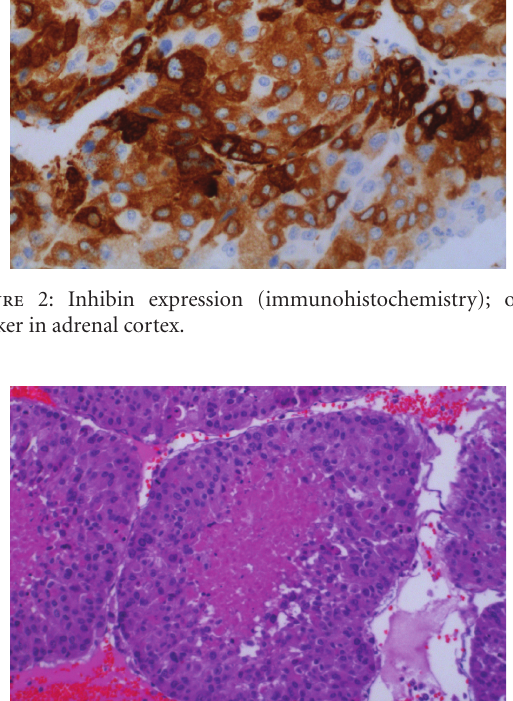
Figure 1: Pre- (a) and postoperative (b) CT scan showing tumour thrombosis of the left renal vein and later vascular result.